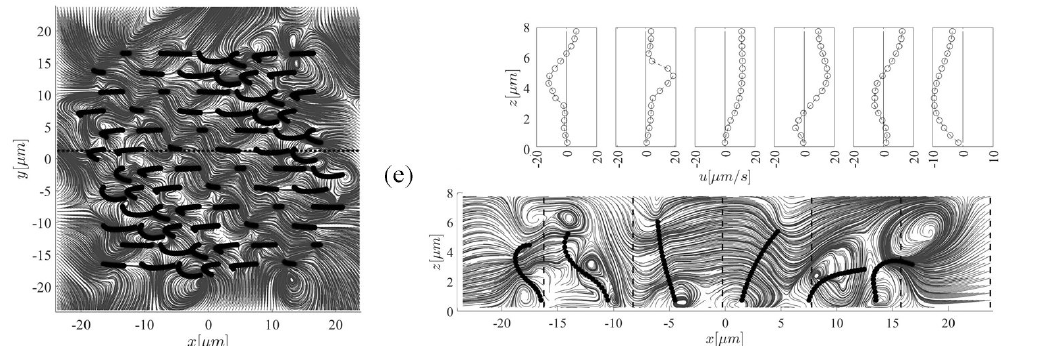
Figure 6. Snapshots of the streamlines and fluid velocity profiles in the x -direction (upper-right panel) taken at five different instants (i.e., ( b ) t = 0 s, ( b ) t = 0.02 s, ( c ) t = 0.04 s, ( d ) t = 0.06 s, and ( e ) t = 0.08 s) within the stable beating cycle (T = 0.1 s) to highlight the cilia-driven flow mechanism and the fluid mixing. In case ( b ), cilium 1 stands up to perform its effective stroke that continues up to the instant t = 0.04 s (case ( c )), after which, the recovery phase (case ( d )) begins. This motion continues and the cilium arrives to its initial position (case ( a )). Left and right panels show the top and side views of the computational domain, respectively. Note that for better clarity of the velocity profiles, the x -axis in each plot has a different scale.